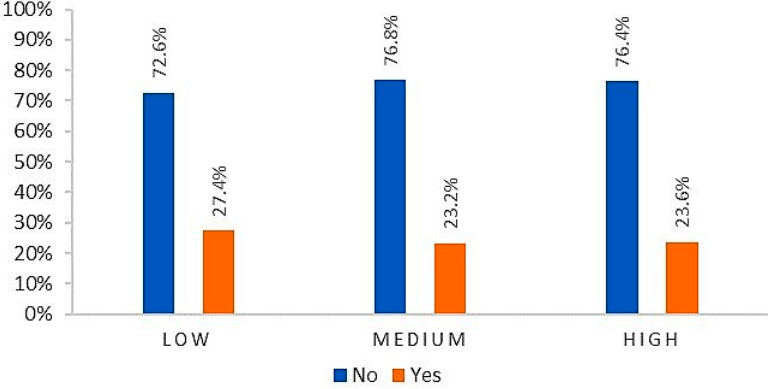
Figure 22. The level of religiosity and engaging in informal practices.